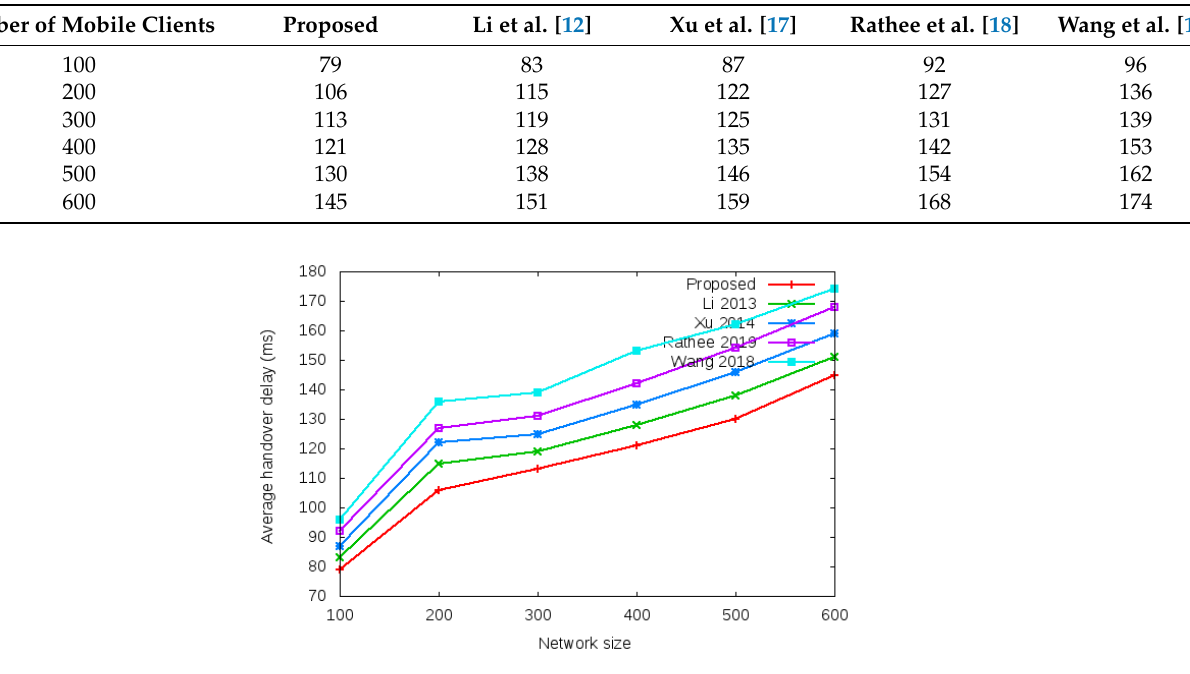
Figure 15. Average handover authentication